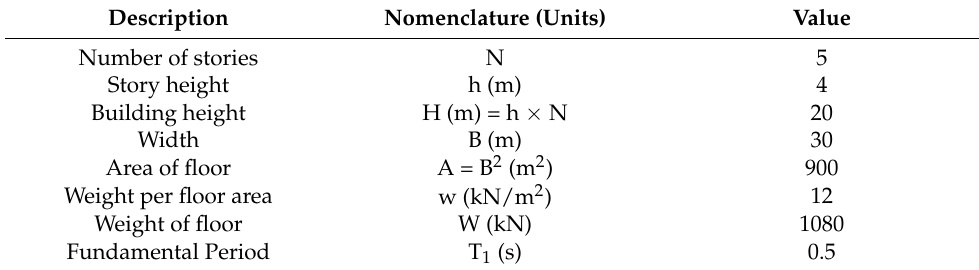
Table 3. Structural configuration of the case study.